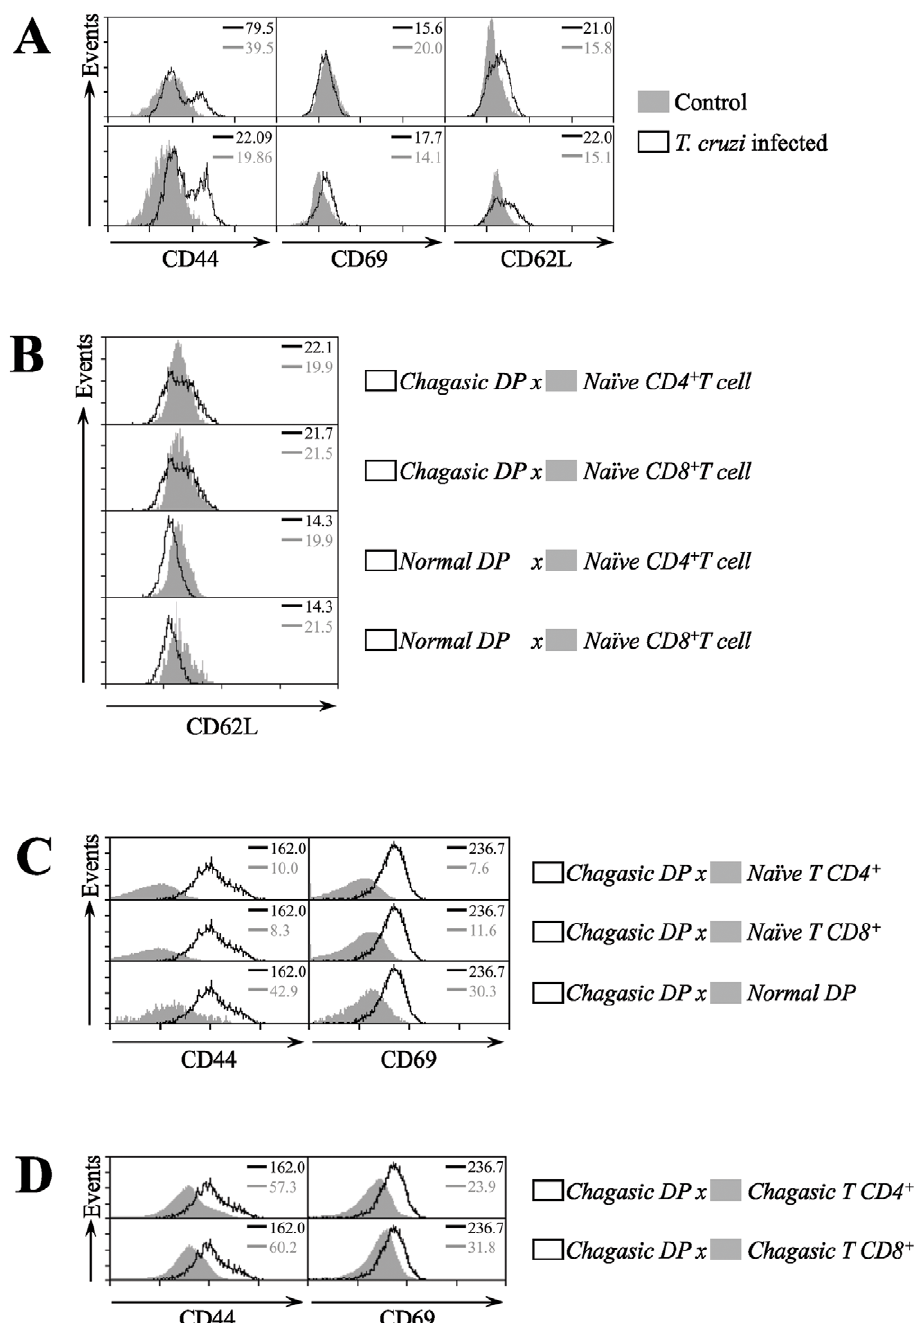
Figure 5. Activation markers in lymphocytes from thymus and subcutaneous lymph nodes of T.cruzi infected mice. Mice were infected with T. cruzi and 15 days later lymphocytes were isolated from thymus and subcutaneous lymph nodes. (a) Thymocytes were stained with CD4-PE, CD8-APC and marker-specific fluorescein isothiocyanate-labeled antibodies prior to flow cytometry analysis. The histograms represent the expression of the CD44, CD69 and CD62L markers in total thymocytes (upper panel) and CD4 + CD8 + T cells (lower panel) from chagasic and normal mice. (b) Comparison of the CD62L expression level from normal or chagasic CD4 + CD8 + T cells versus normal single-positive CD4 + and CD8 + T cells undergoing intrathymic maturation. Panel (c) depicts representative histograms of CD4 + CD8 + from T. cruzi infected subcutaneous lymph nodes (solid lines), compared with naı¨ve CD4 + and CD8 + T cells obtained from non-infected mice. (d) Representative histograms of CD44 and CD69 expression in CD4 + CD8 + T cells, activated single-positive CD4 + and CD8 + T cells from subcutaneous lymph nodes obtained from T. cruzi infected mice. Animals were sacrificed on day 15 post-infection. The data are representative of three independent experiments. The values on the upper right corner indicate the mean fluorescent intensity of the expression of the markers from each histogram. Differences between chagasic DP and activated T cells versus naı¨ve T cells are significant ( P , 0.05). These data are representative of three independent experiments using five mice per group.